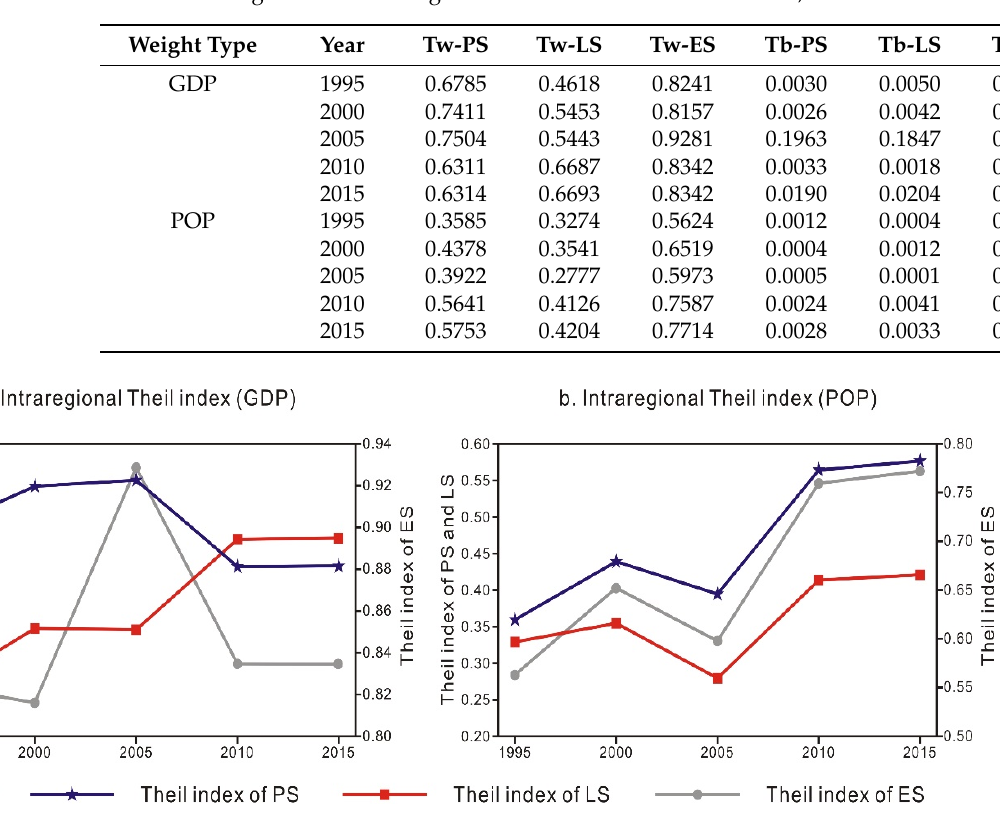
Table 5. Interregional and intraregional Theil index values of the PLES, 1995–2015.